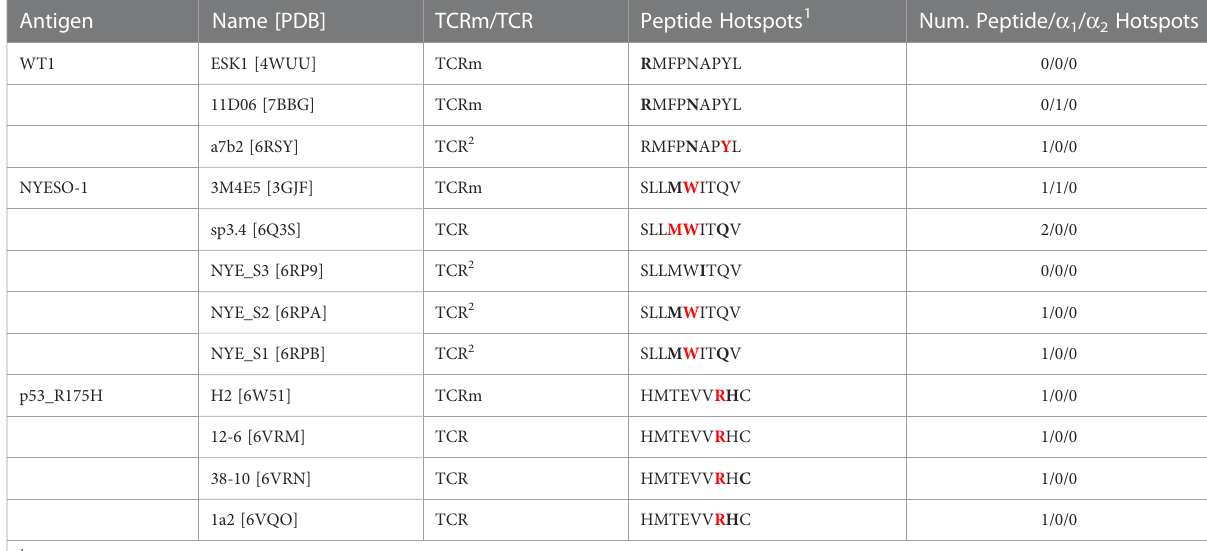
TABLE 1 Decomposed per-residue energetic pro fi les for the case study TCR and TCRm complexes, grouped by pMHC region (peptide, MHC a 1 helix, or MHC a 2